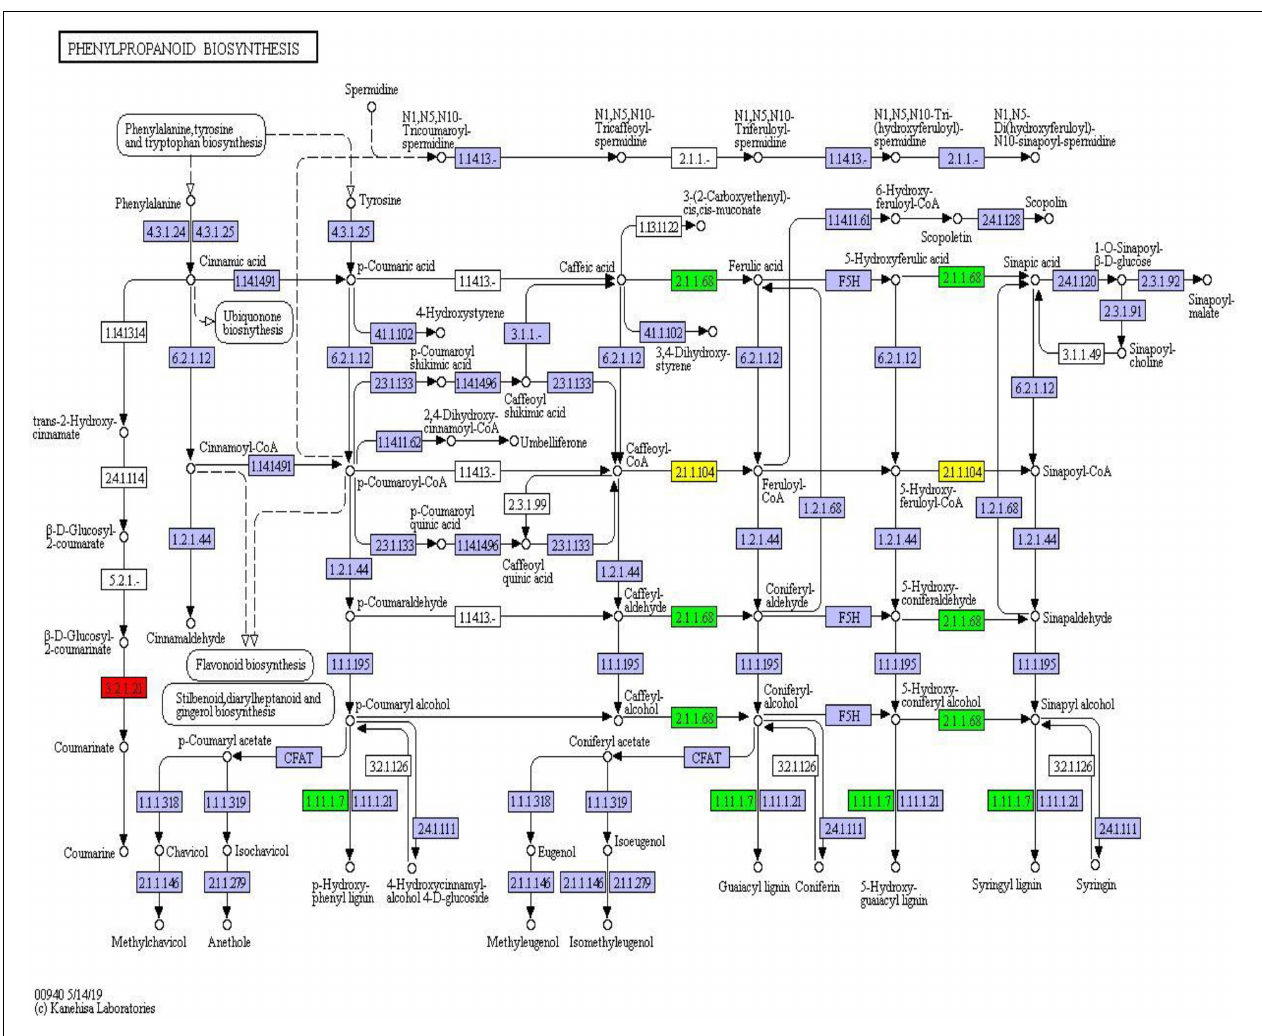
FIGURE 9 | Phenylpropanoid synthesis pathway and differential protein expression. The red box represents the upregulated protein; the green box represents the down-regulated protein; the yellow box contains both up- and downregulated proteins.